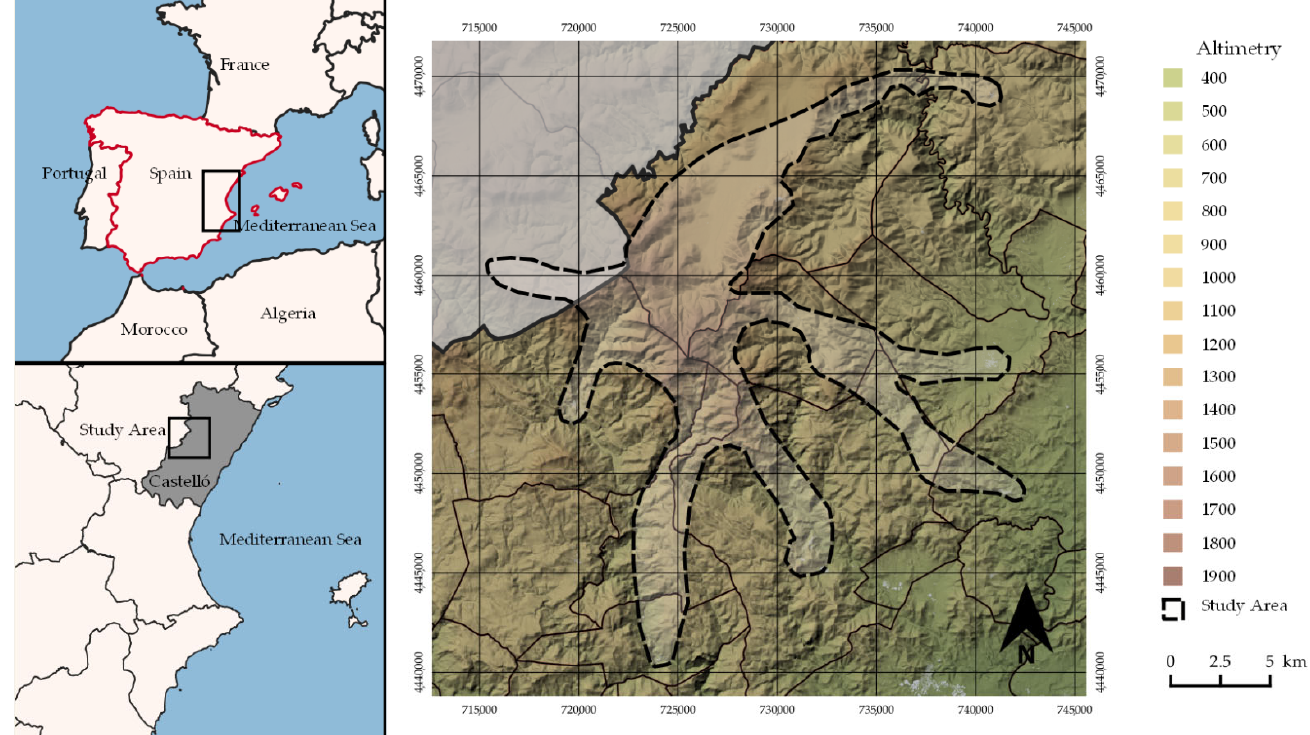
Figure 1. Location and delimitation of the study area and orographic characteristics of the province of Castelló. Source: authors.